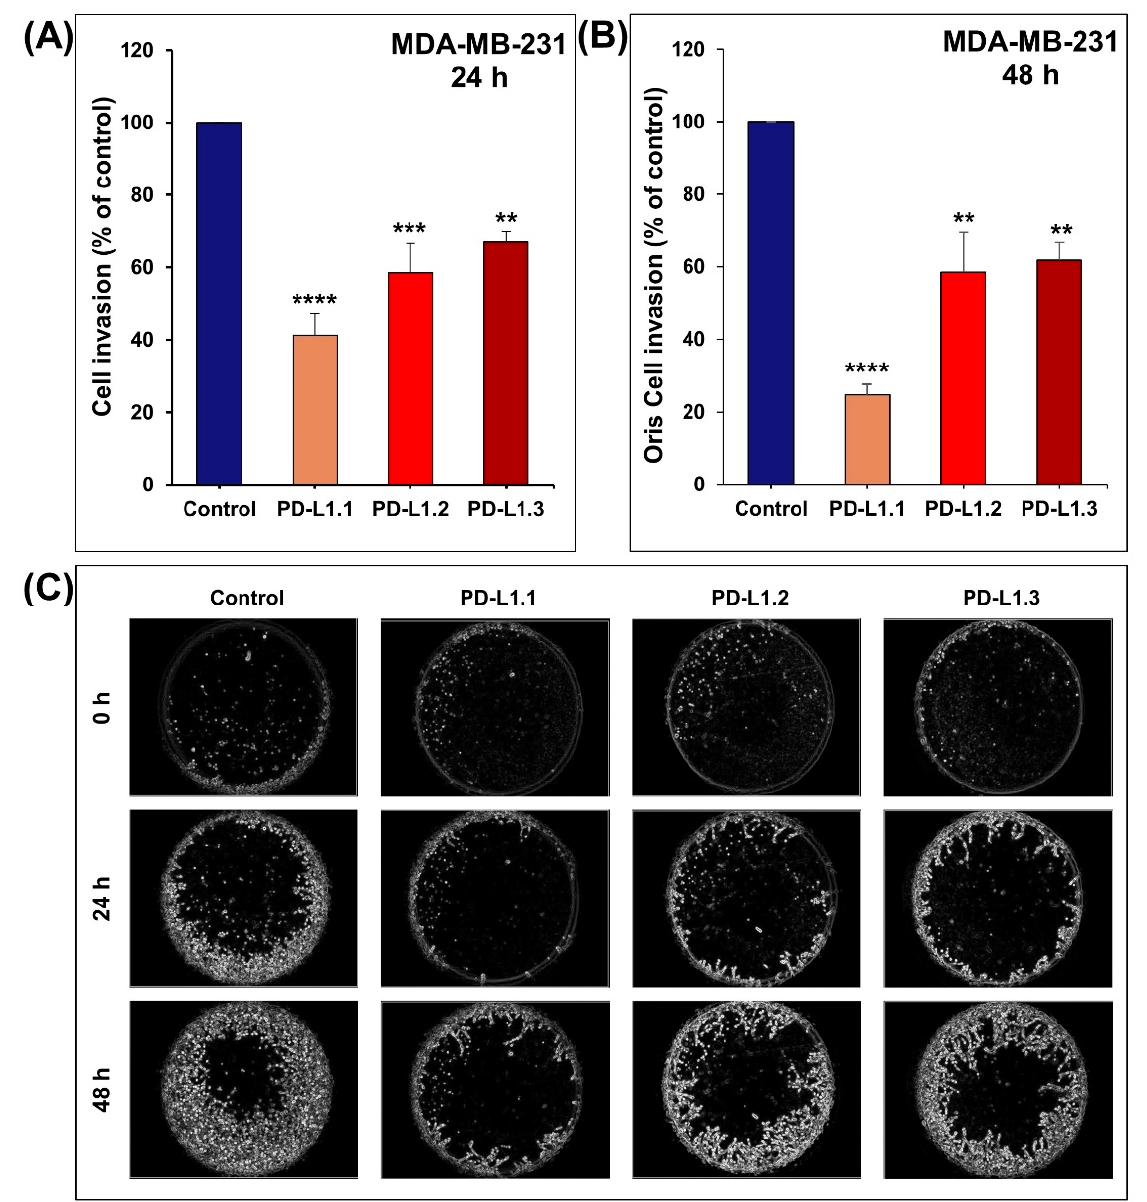
Figure 5. PD-L1 knockout significantly decreases MDA-MB-231 invasion in vitro. ( A ) Using Boyden Matrigel invasion chamber assay, control and PD-L1 knockout cells were seeded in the upper chamber for 24 h. The invading cells into the lower chamber were determined using CellTiter-Glo Luminescent. ( B , C ) Using Oris Matrigel invasion assay, invasion of the control and PD-L1 knockout cells into the detection zone was monitored for 24 and 48 h. Experiments were repeated at least 3 times. Columns are means; bars are S.E.M. ** p < 0.01. *** p < 0.001. **** p < 0.0001.